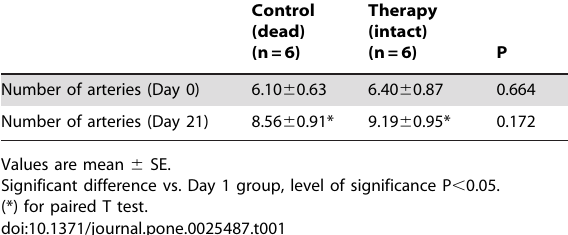
(*) for paired T test.